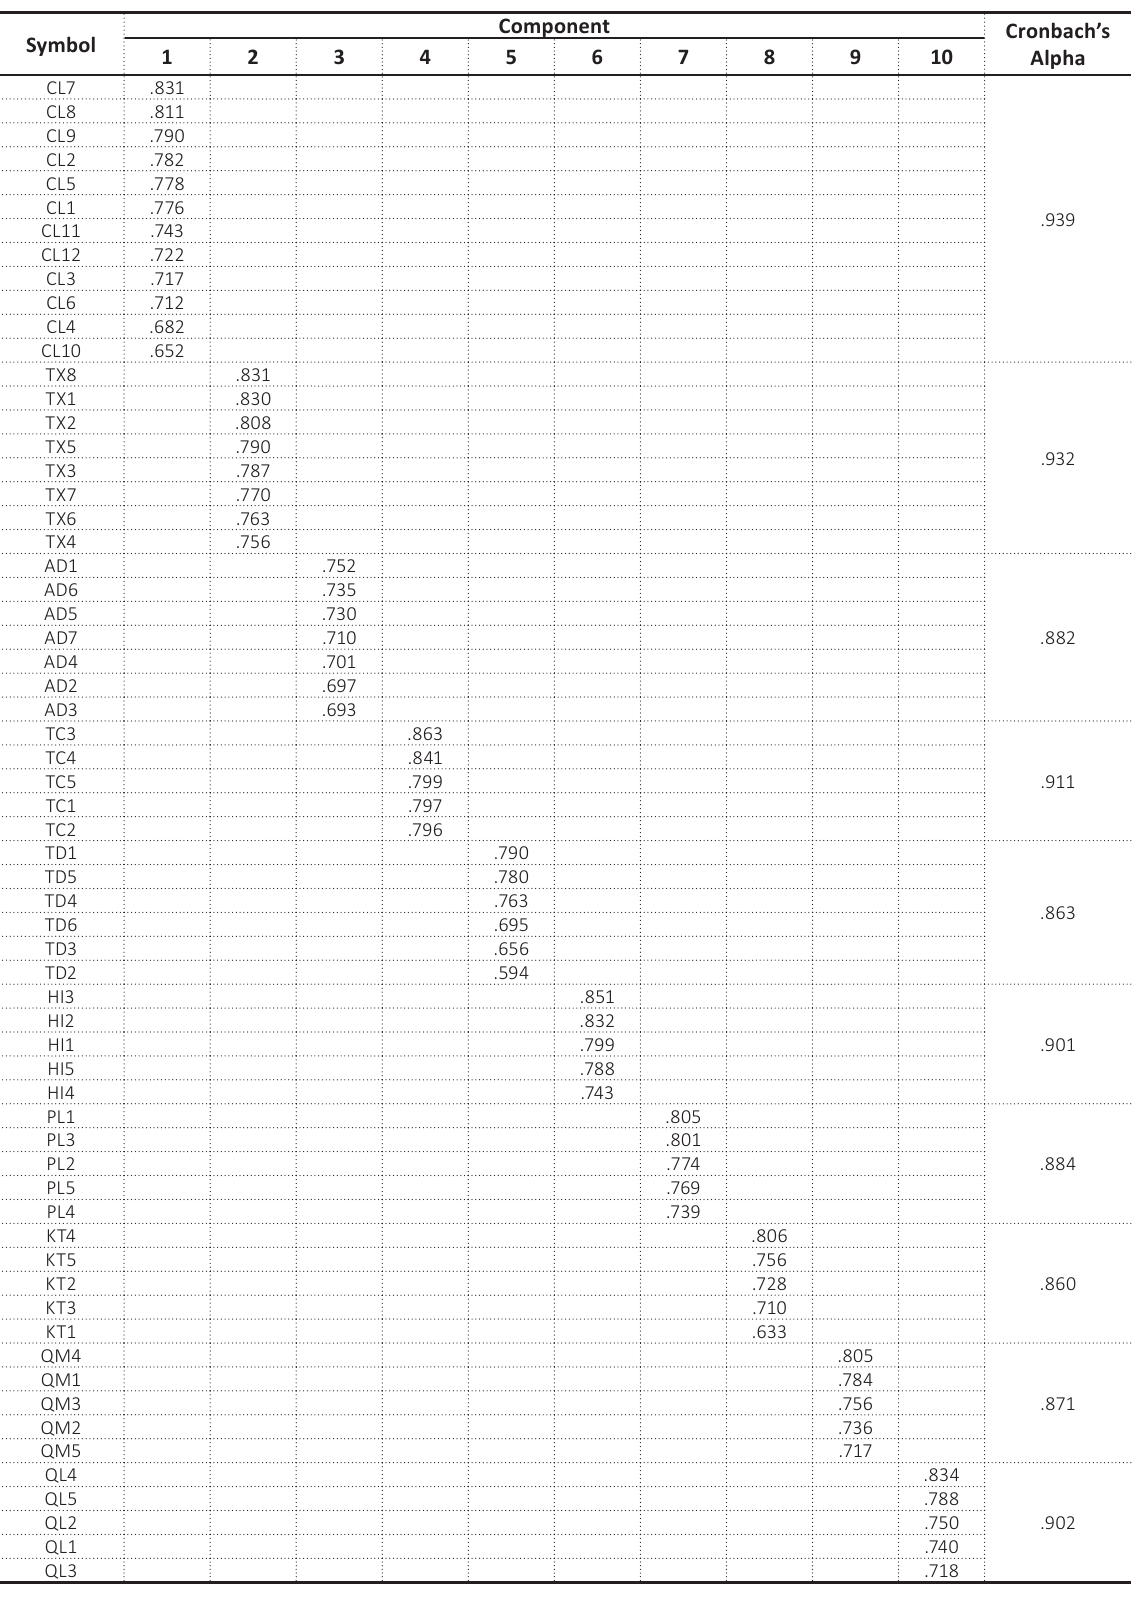
Table B1. Rotated component matrix and Cronbach’s